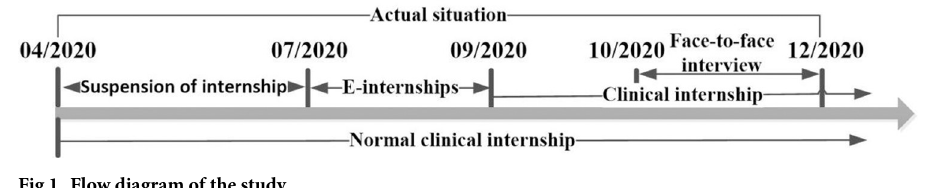
Fig 1. Flow diagram of the study.